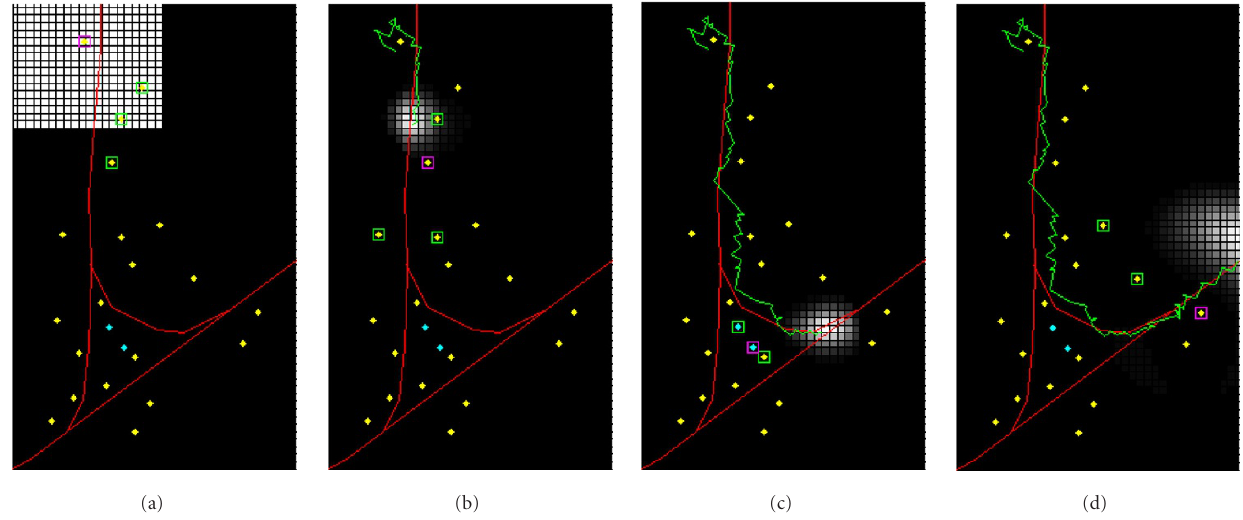
Figure 13: Snapshots of an AAV run on the north-east road. Plotting convention is the same as in Figure 8. The red curves are the roads. The green curve is the estimated